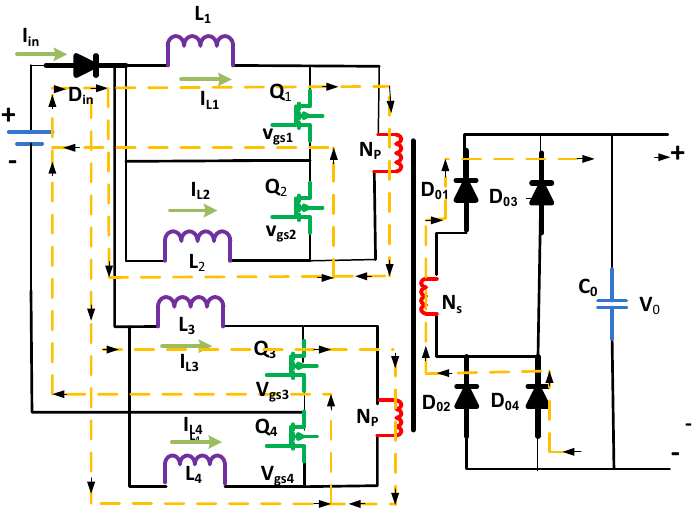
Figure 5. Third mode of the circuit.